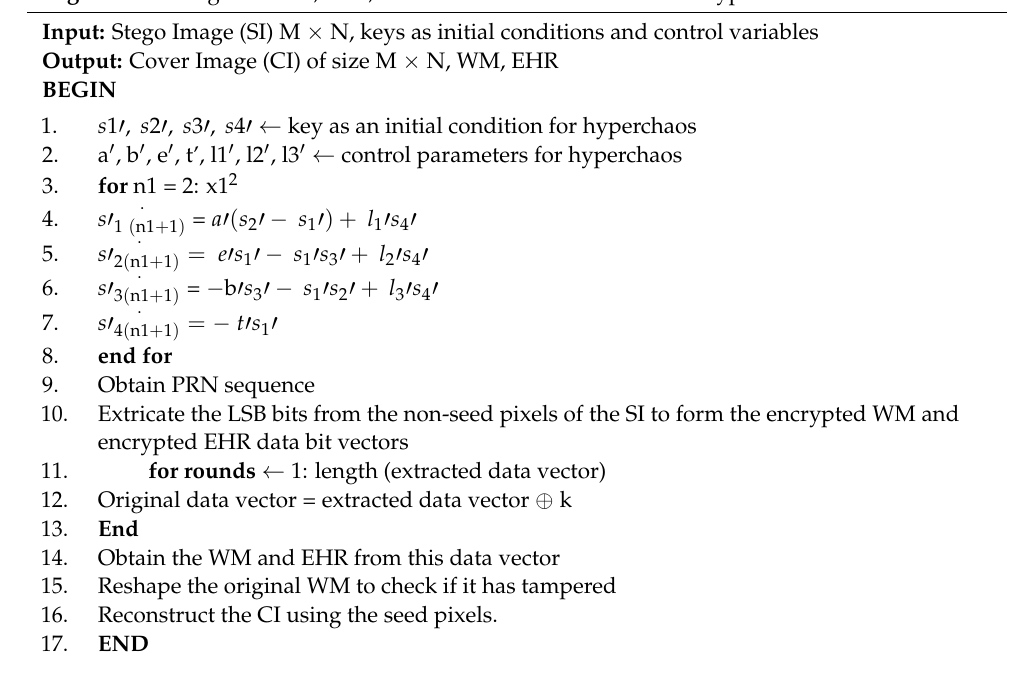
Algorithm 2. CI generation, WM, and EHR data extraction and